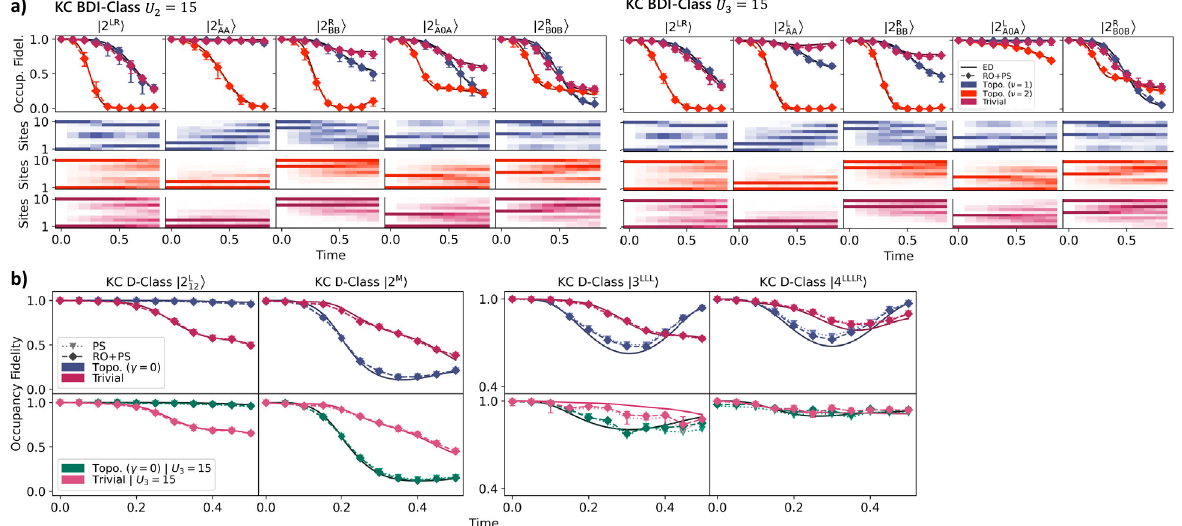
Fig. 4 Stabilizing multi-fermion states in the BDI- and D-class interacting KC models. a In BDI-class H KC , the stability of 2-fermion boundary states competes with the topological localization when interactions U 2 or U 3 are nonzero. U 2 and U 3 preferentially stabilize the left successive sublattice A (AA0) and next successive sublattice A (A0A) modes respectively. b In D-class H KC , the U 3 interaction stabilizes the 3- and (cid:4) (cid:4) (cid:5) (cid:5) (cid:4) (cid:4) and 4 LLLR , which are unstable originally. Time-evolution results are for N = 5 unit cells ( n = 10 qubits), with error bars 4-fermion states 3 LLL obtained from repeated experiments. See Table 2 for detailed parameter speci fi